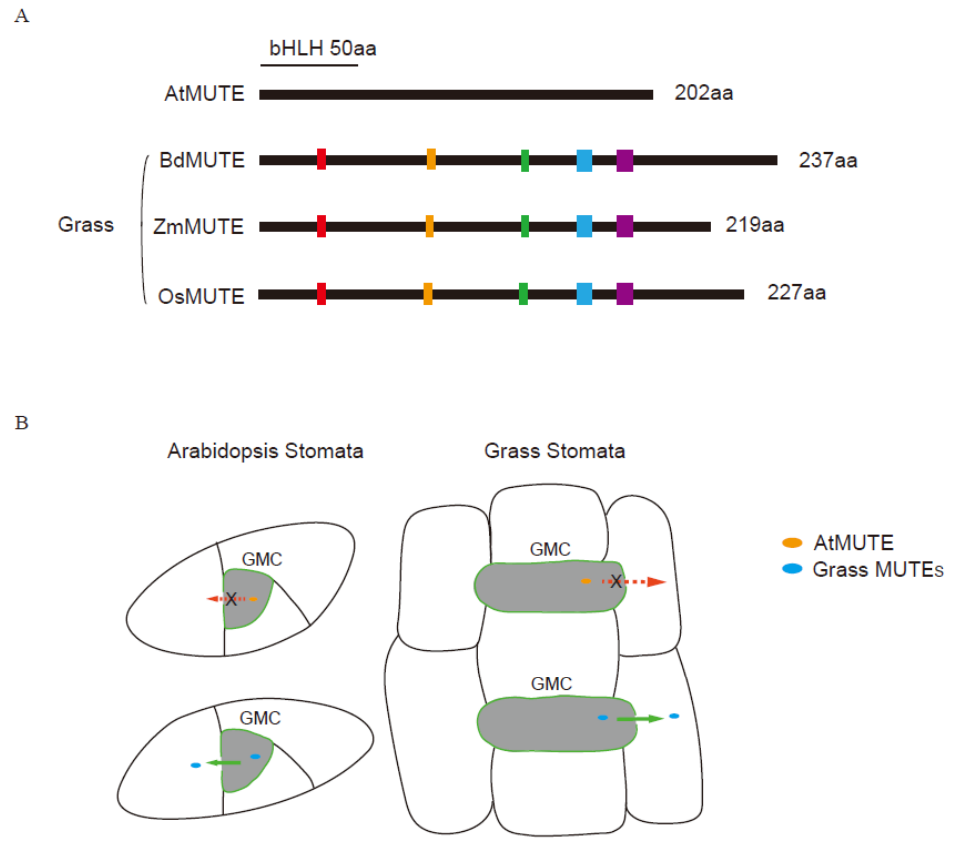
Figure 2. Schematic diagrams showing the mobility of homologous MUTE proteins in Arabidopsis and grasses. ( A ) Schematic diagram of potential residues controlling the mobility of MUTE proteins. MUTE orthologs of the representative grass species Brachypodium (BdMUTE–Bradi1g18400), maize (ZmMUTE-GRMZM2G417164) and rice (OsMUTE, LOC_Os05g51820) were aligned with the representative eudicot species Arabidopsis (AtMUTE, At3g06120). Colored-boxes represent the potential motifs responsible for mobility regulation. ( B ) Mobility of MUTE orthologues in grass and Arabidopsis . In Arabidopsis , YFP-BdMUTE/ZmMUTE/OsMUTE driven by the GMC-specific AtMUTE promoter was visible in the neighboring cells, unlike GMC-only expression of AtMUTE-YFP (Left panel). AtMUTE-YFP expressed in grass stomata driven by the promoter of grass MUTE is restricted in GMC and does not move to the neighboring cells, whereas BdMUTE, ZmMUTE, and OsMUTE can move from the GMC to the adjacent SMC (Right panel). GMC (guard mother cell), dark gray. Grass MUTE proteins, blue oval. AtMUTE protein, orange oval. Red/Green arrows indicate the MUTE proteins cannot/can move through plasmodesmata, respectively.